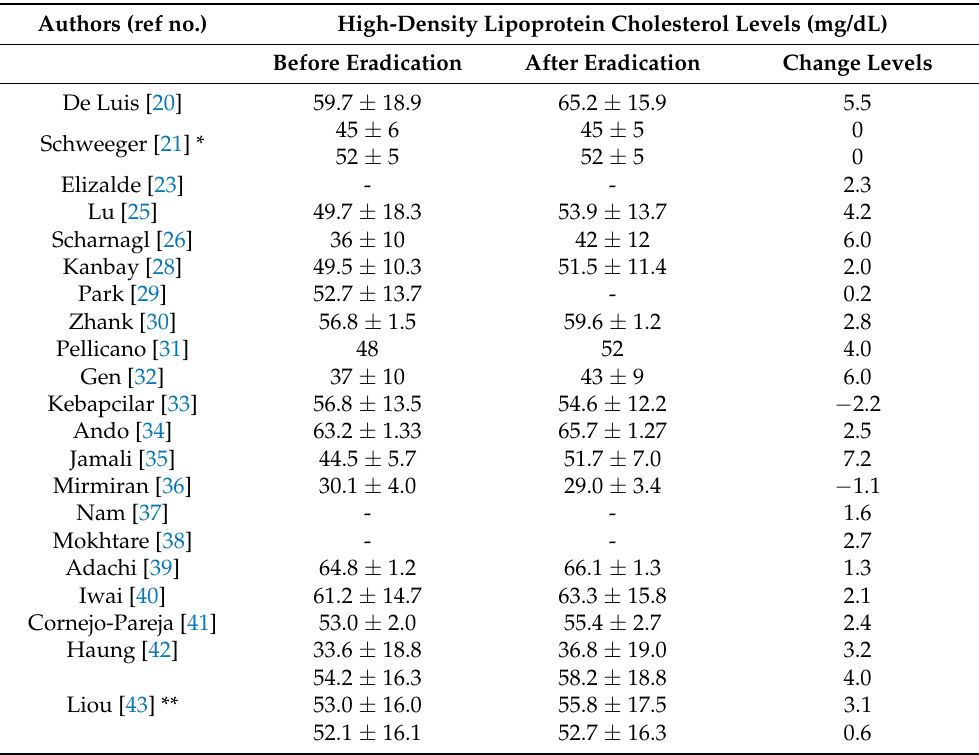
Table A1. Summary of levels of high-density lipoprotein cholesterol before and after eradication. Authors (ref